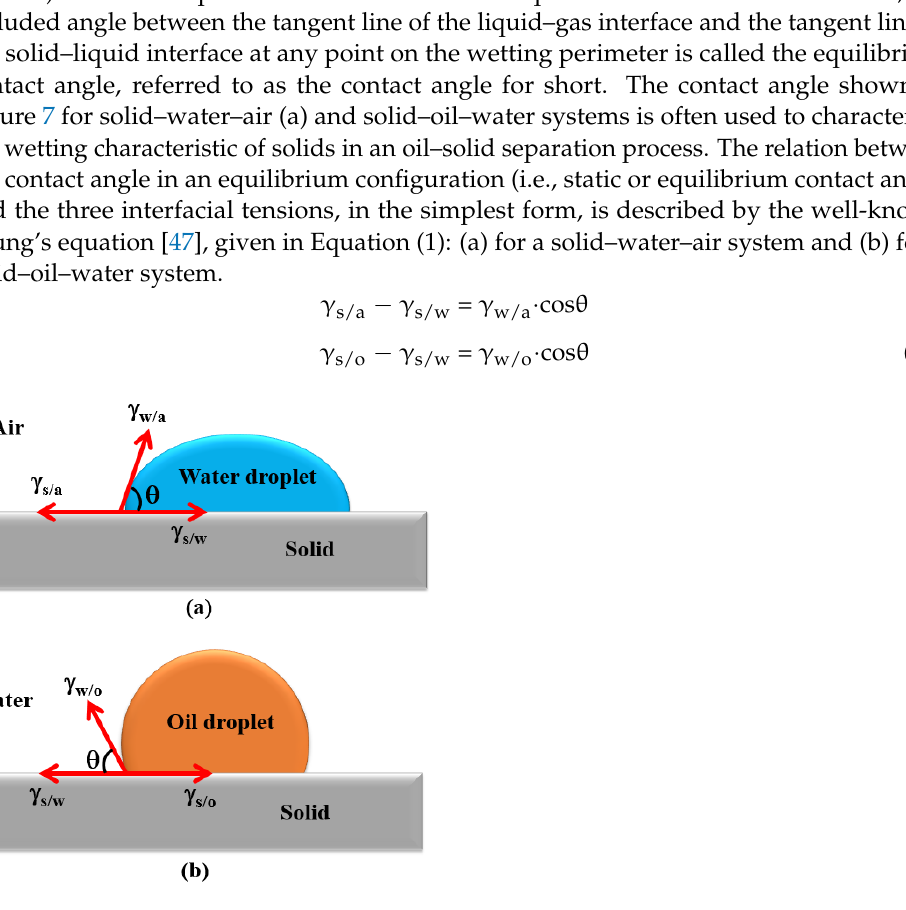
Figure 7. Schematics of contact angle for two systems: ( a ) solid–water–air system and ( b ) solid–oil– water system.